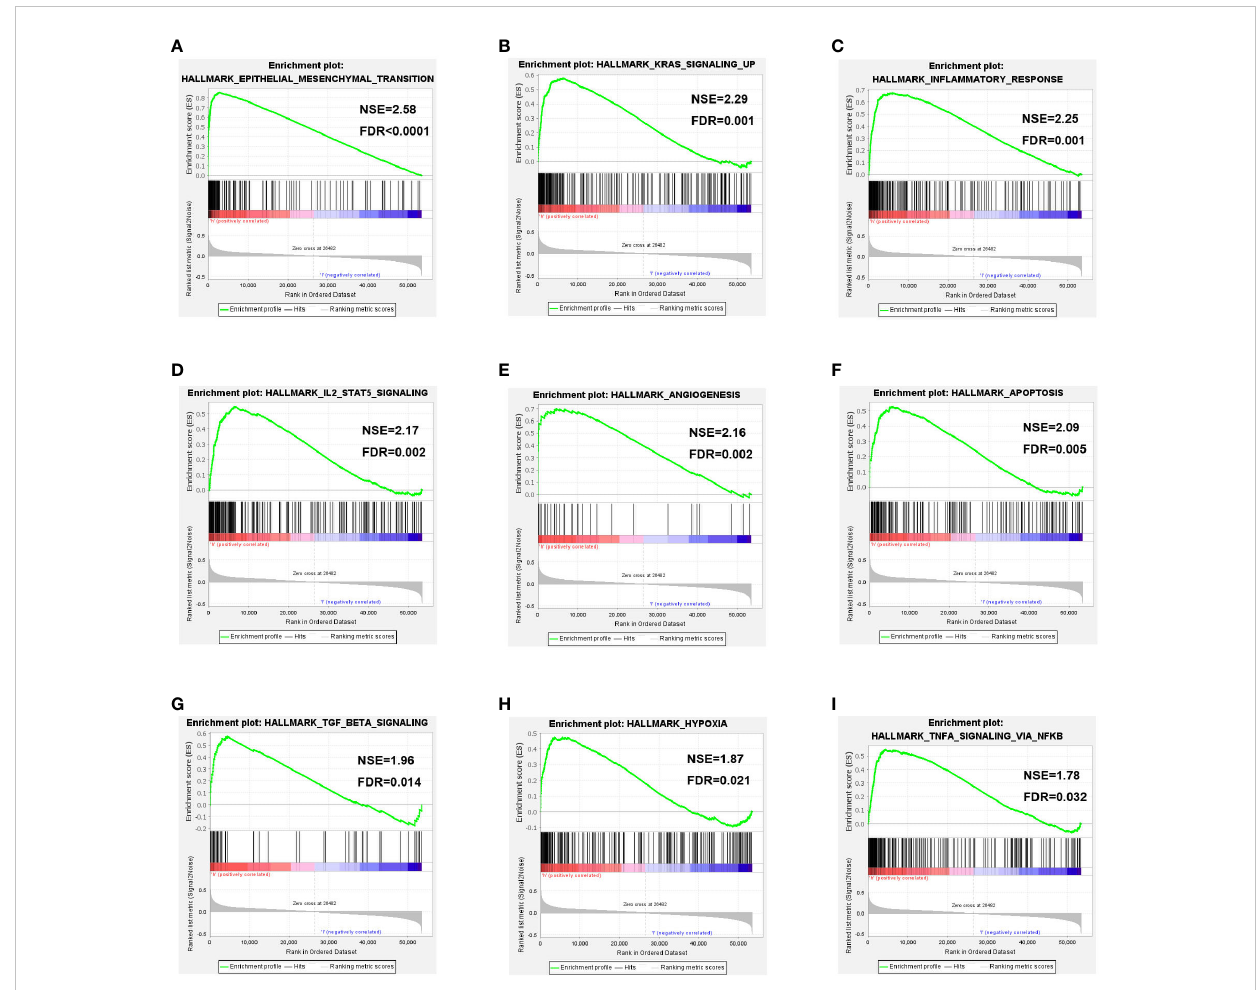
FIGURE 5 Gene set enrichment analysis. Pathway enriched in the epithelial-mesenchymal transition (EMT, A ), KRAS signaling up (B) , in fl ammatory response (C) , IL2-STAT5 signaling (D) , angiogenesis (E) , apoptosis (F) , TGF- b signaling (G) , hypoxia (H) and TNF- a signaling via NF- k B (I)